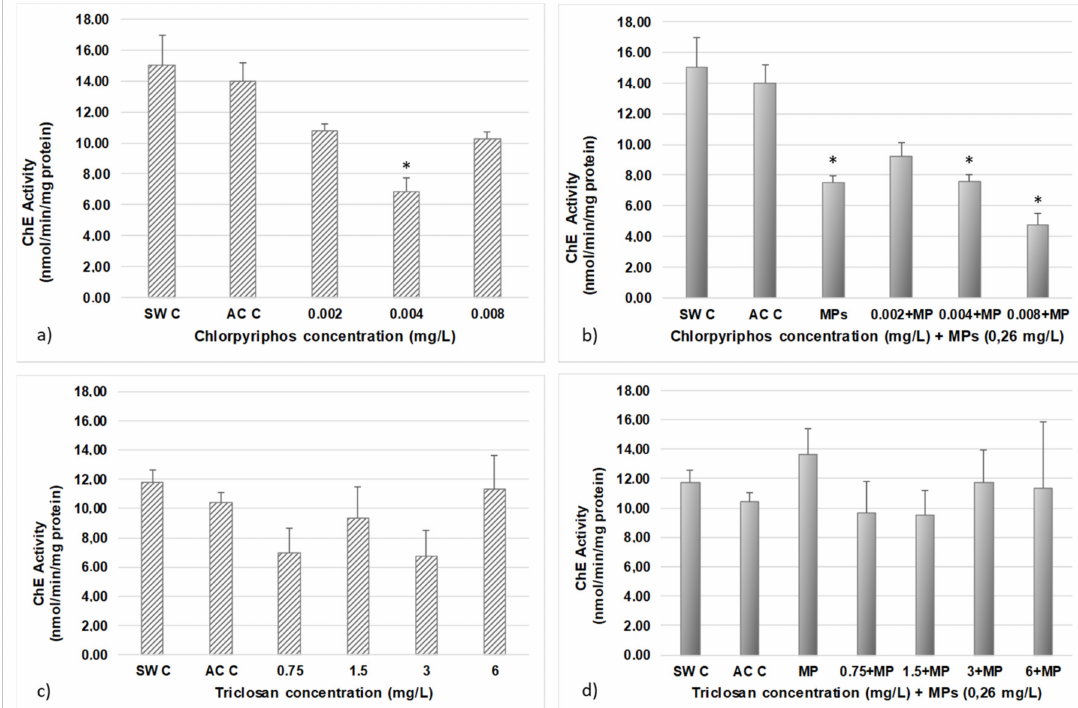
Figure 5. ChE activity of A. salina after 48 h of exposure to different contaminant concentrations: ( a ) CPF, ( b ) CPF + MP, ( c ) TCS and ( d ) TCS + MP. Error bars represent standard deviations. * Significantly different between controls and other treatments ( p >